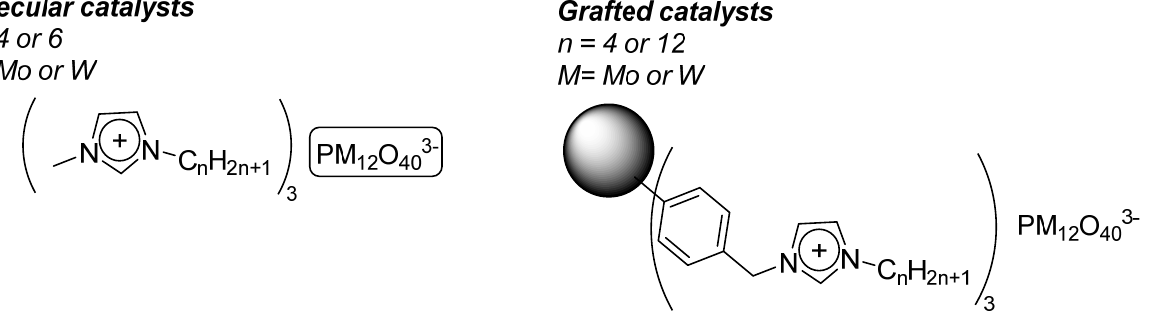
Figure 23. molecular and grafted catalysts on functionalized Merrifield resin.